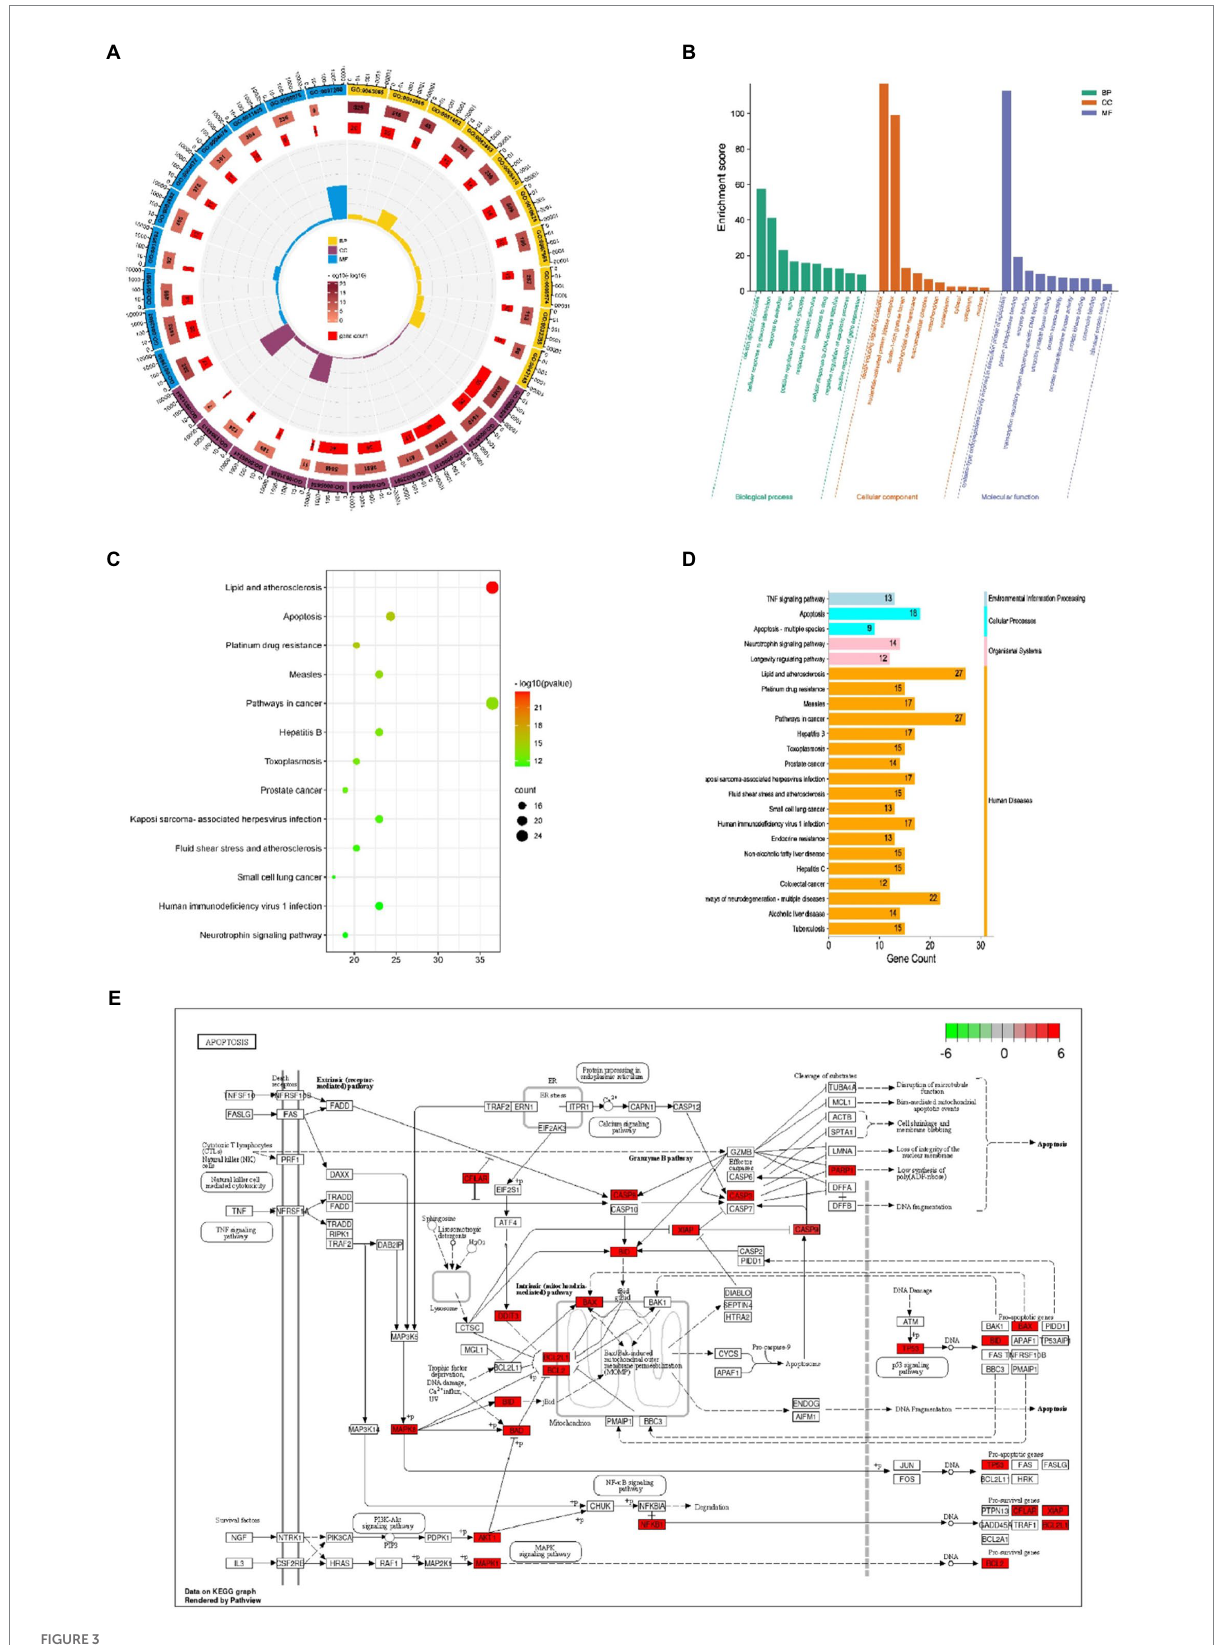
FIGURE 3 GO annotation of the Cordycepin-anti-Alzheimer disease targets (A,B) ; KEGG pathway analysis of Cordycepin-anti-Alzheimer disease targets (C,D) ; apoptosis pathway (E) . The red mark represents enrichment of the target of Cordycepin in the apoptosis